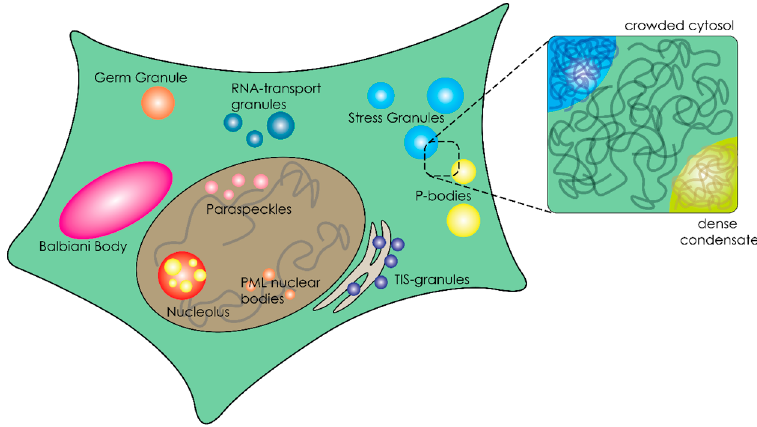
Figure 1. Schematic overview of a eukaryotic cell containing membranous and membraneless Figure1. organelles.